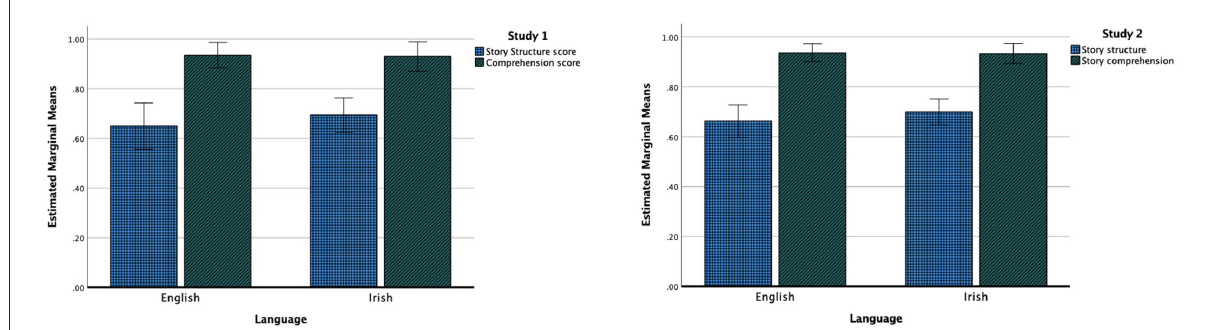
FIGURE1 The MAIN story structure and story comprehension scores and standard deviations across Irish and English in Study 1 and Study 2.